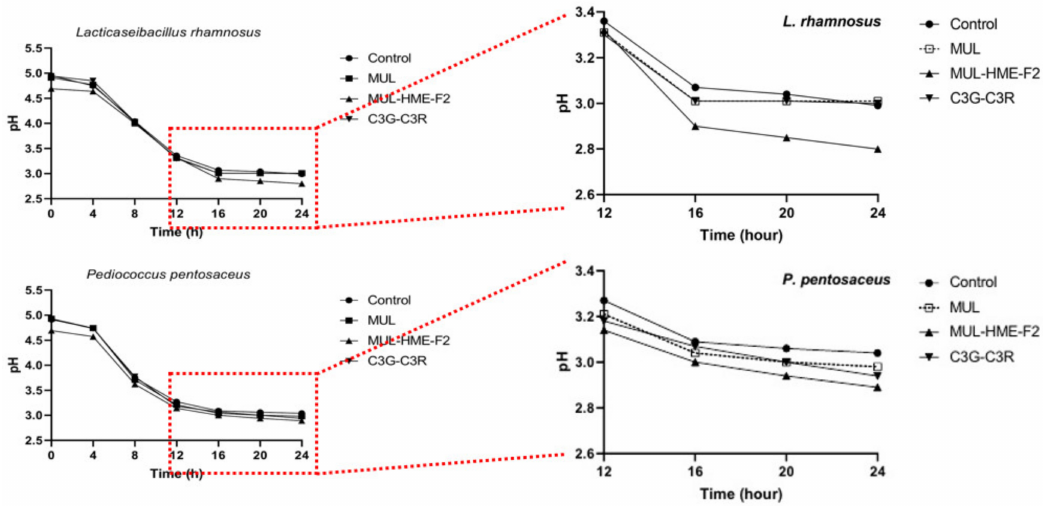
Figure 8. Changes of pH value for L. rhamnosus and P. pentosaceus treated with mulberry raw materials (MUL) and HME-DDS formulation (HME-MUL-F2). LAB probiotics were co-cultured with sample in MRS broth for 24 h. The decrease in pH according to the treatment with HME-MUL-F2 can be explained by the HME-DDS. The HME-DDS preparation could improve the growth and metabolism of the LAB strain. A large amount of organic acid was formed by the probiotics strain, which promoted the growth of the